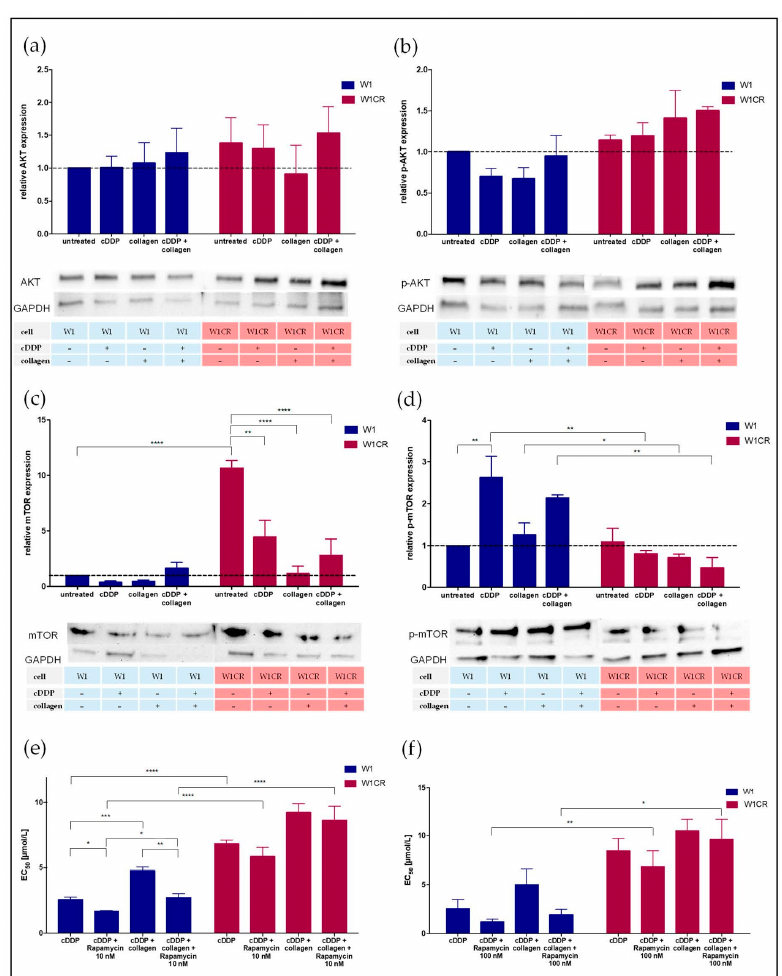
Figure 3. An insight into the AKT / mTOR signaling axis for W1 and W1CR cells. ( a – d ) Western blot of W1 and W1CR cells to illustrate the expression of AKT ( a ), p-AKT ( b ), mTOR ( c ), and mTOR in its phosphorylated form ( d ). Inhibition of mTOR in W1 and W1CR cells by rapamycin, which specifically blocks mTORC1 in a concentration of 10 nM ( e ) and 100 nM ( f ) and its impact on cisplatin sensitivity. Data are means of at least n = 3 ( ± SEM), asterisks indicate statistical significance: * p < 0.05; ** p < 0.01; *** p < 0.001; **** p <